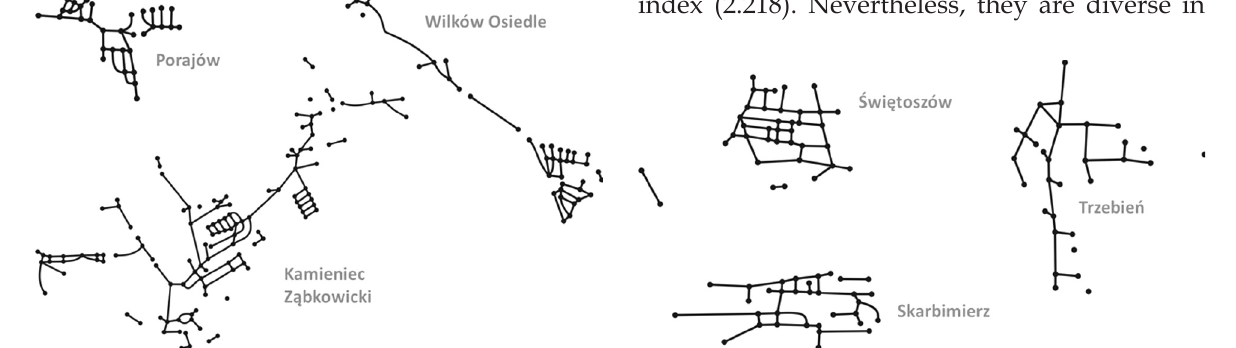
Fig. 11. Graphs depicting the morphology of former military settlements (DT). Source: own